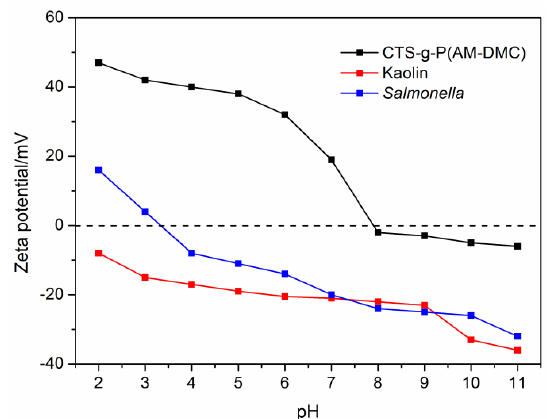
Figure 6. Zeta potential (ZP) vs. pH profiles of CTS- g -P(AM-DMC), kaolin suspension, and Salmonella